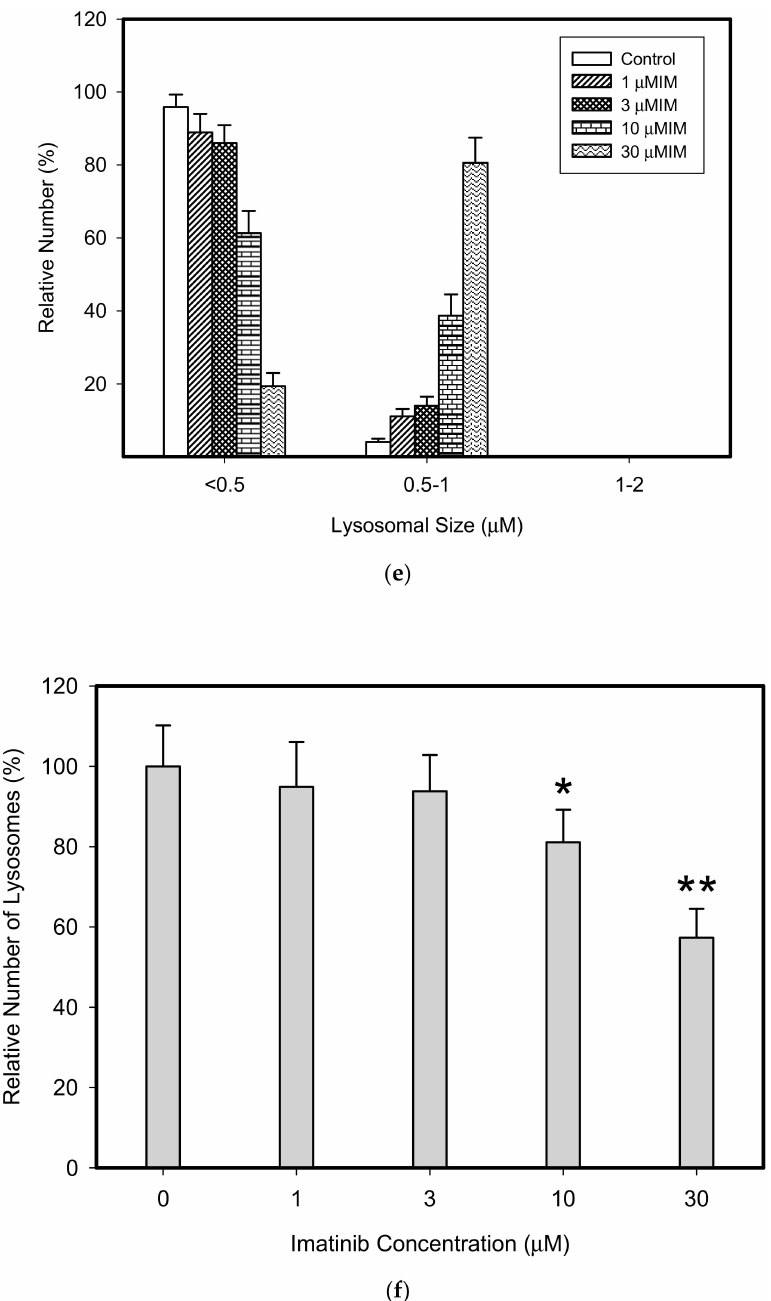
Figure 6. E ff ect of TKIs on lysosomal morphology in HL-60 cells. Cells were cultured for 6 h in the presence of particular TKI under standard conditions and then fixed in paraformaldehyde and subjected to the immunostaining of LAMP1. Cells cultured in medium without TKIs were taken as a control. ( a ) Morphologic changes in lysosomes in IM treated cells (typical analysis). ( b ) Quantitative analysis of lysosomal size in IM treated cells. ( c ) Quantitative analysis of the number of lysosomes in IM treated cells. ( d ) Morphologic changes in lysosomes in GF treated cells (typical analysis). ( e ) Quantitative analysis of lysosomal size in GF treated cells. ( f ) Quantitative analysis of the number of lysosomes in GF treated cells. Lysosomal morphology was evaluated in at least 250 cells for each treatment. The results are represented as means of four independent experiments with standard deviations. * denotes significant change in the relative number of lysosomes ( p < 0.05) between TKI treated and control cells. ** denotes significant change in the relative number of lysosomes ( p < 0.01) between TKI treated and control